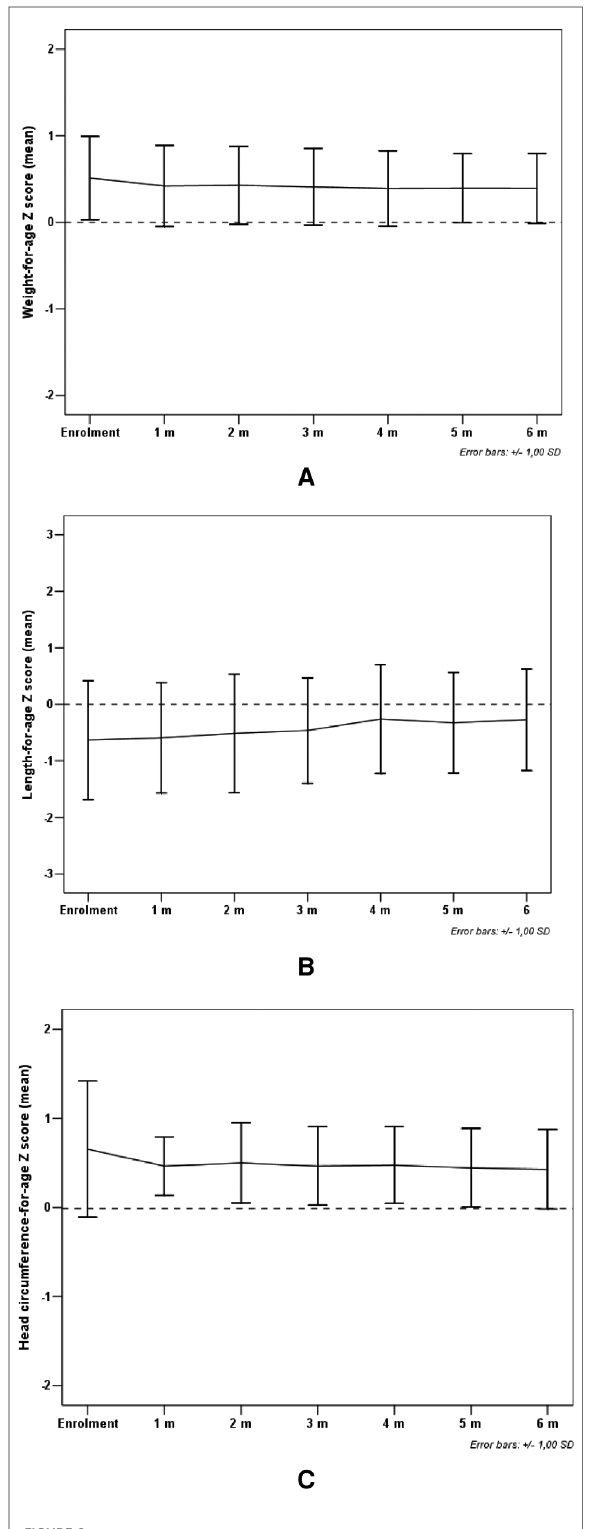
FIGURE 2 Mean weight-for-age Z score (panel A ), length-for-age Z score (panel B ) and head circumference-for-age Z score (panel C ) from enrolment during 6-m period follow-up. Error bars indicate ±1 standard